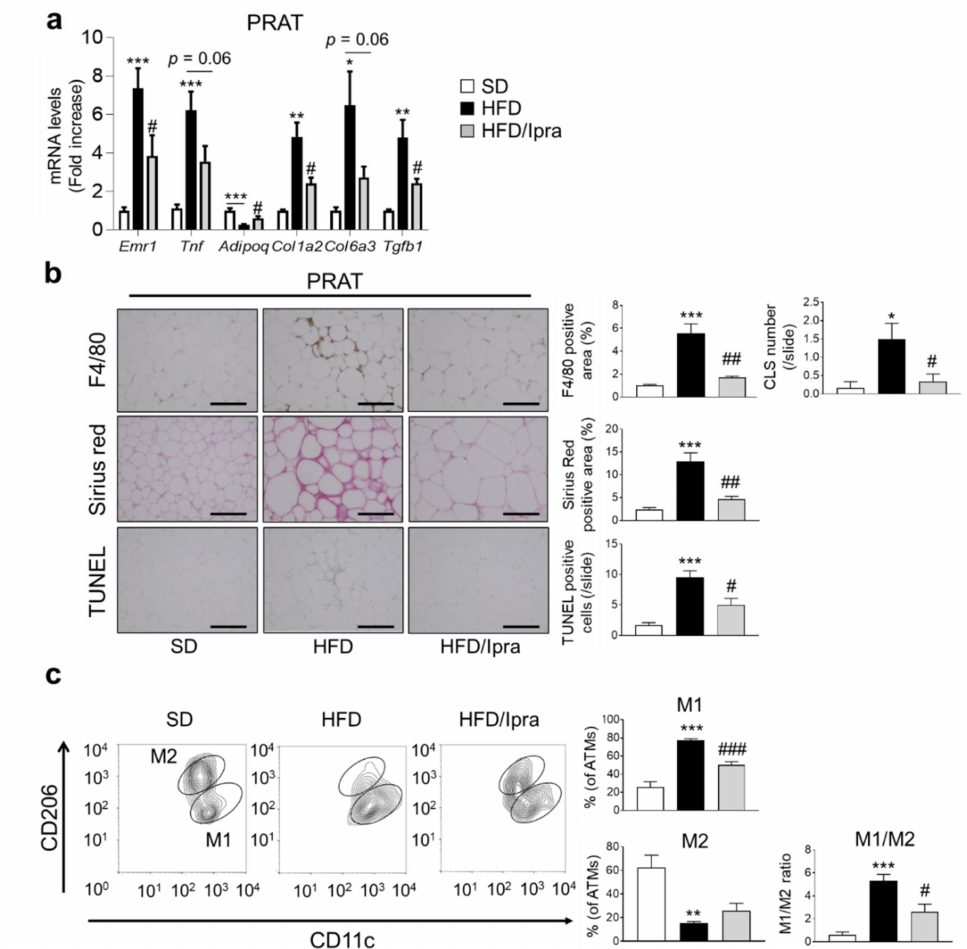
Figure 2. Ipra attenuates HFD-induced inflammation, fibrosis, and cell death in PRAT. ( a ) Expres- sion levels of inflammation- and fibrosis-related genes in PRAT of SD- or HFD-fed WT mice after 6 weeks of Ipra treatment. ( b ) Representative images and quantitative data of F4/80 immunostain- ing, Sirius red staining, and TUNEL staining in PRAT. ( c ) Representative plots and quantification of flow cytometry for M1-like (CD11c + CD206 − cells) and M2-like (CD11c − CD206 + cells) ATMs (CD45 + CD11b + F4/80 + cells) in PRAT and M1-like/M2-like ratio. WT, wild-type; SD, standard diet; HFD, high-fat diet; Ipra, ipragliflozin; PRAT, perirenal adipose tissue; TUNEL, TdT-mediated dUTP nick end labeling; ATMs, adipose tissue macrophages. Original magnification, × 200. Scale bar, 1 µ m. * p < 0.05, ** p < 0.01, *** p < 0.001 vs. SD. # p < 0.05, ## p < 0.01, ### p < 0.001 vs. HFD. n =